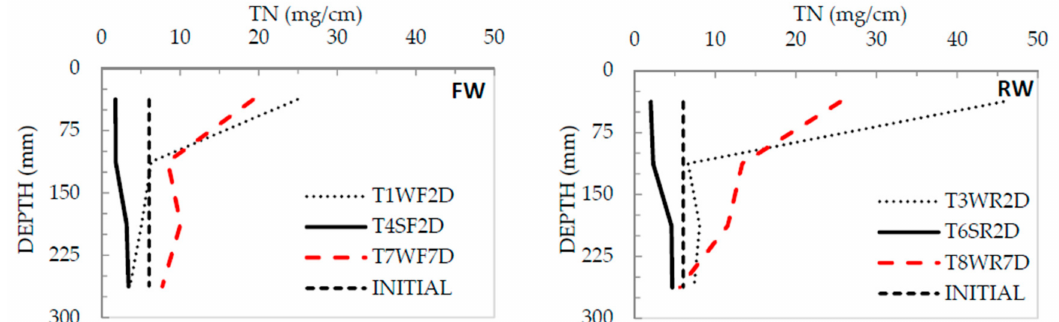
Figure 9. Total nitrogen (TN) level at different soil depths for fresh water (FW) treatments ( left ) and recycled water (RW) treatments ( right ). See Table 2 for treatment descriptions.